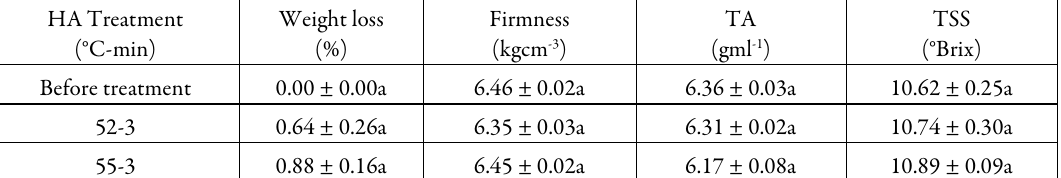
Table 3. Internal quality parameters of mango fruits treated at the most effective hot air (HA) treatments HA Treatment Weight loss (°C-min) (%) Before